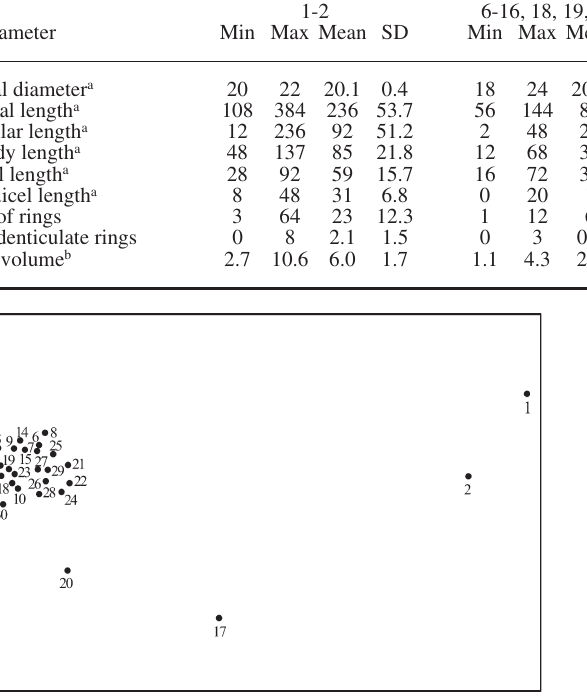
Fig . 5. – Multi-dimensional Scaling ordination of stations based on the mean value of each morphological parameter measured on Helicostomella